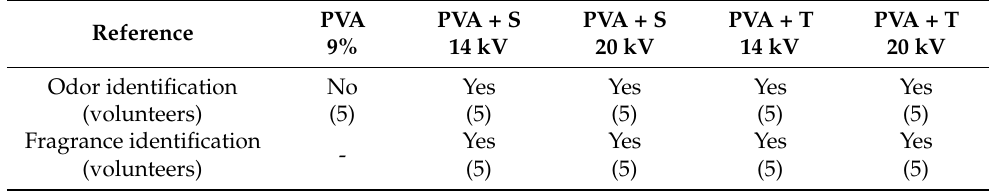
Table 2. Organoleptic test results.